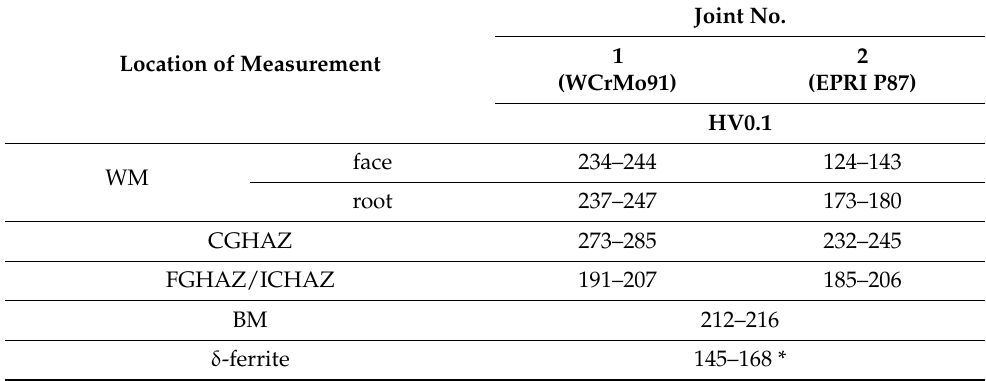
Table 5. Results of microhardness measurement of the test welded joints and δ -ferrite.